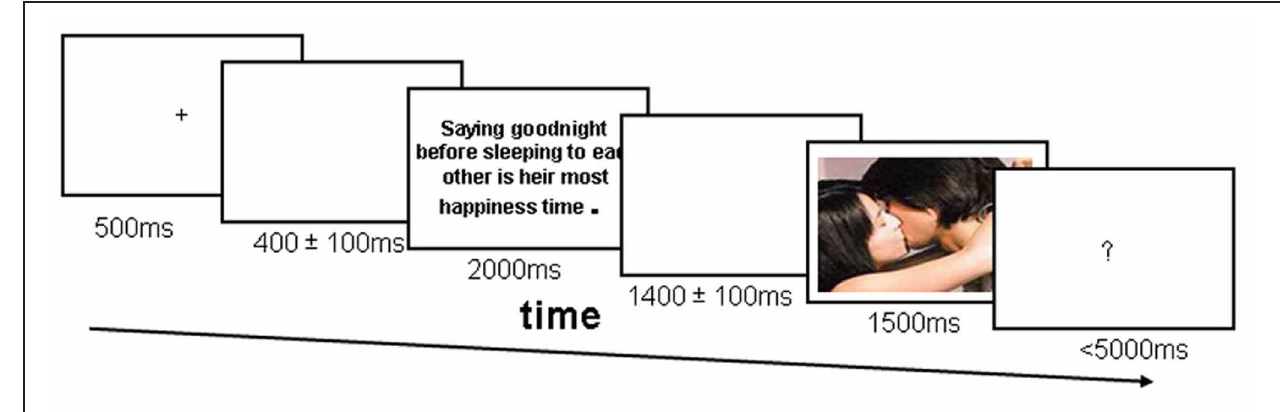
neutral description for a neutral picture (e.g., a computer) might be “This desktop computer belongs to Dike and Amy,” the positive description for the same neutral picture might be “It is the computer that gave them a chance to know each other and fall in